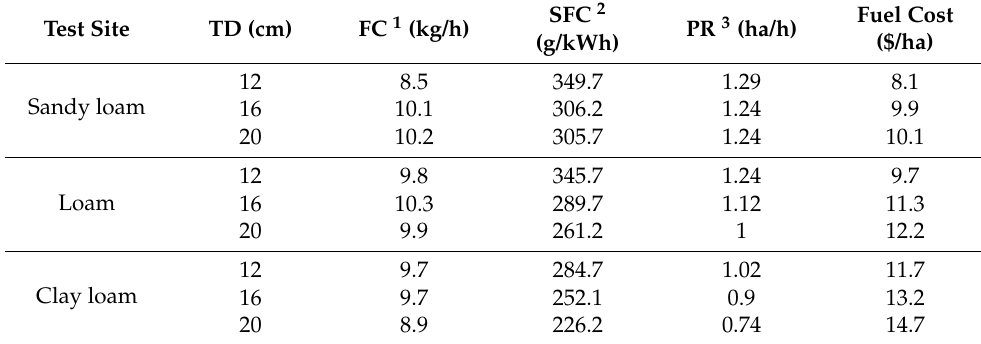
Table 8. Results of fuel efficiency by tillage depth and test